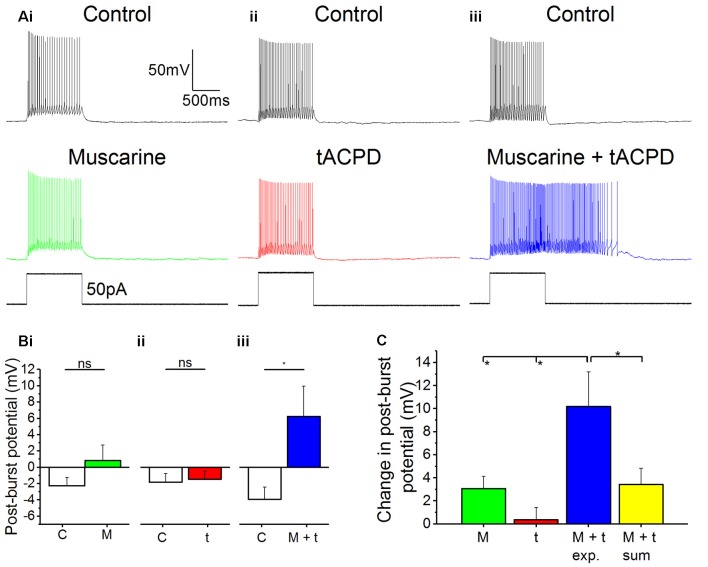
Synergistic effects on post-pulse potential by coapplication of low doses of muscarine and tACPD. (A) Typical responses of OLM cells to a 50 pA 1 s current pulse before and after application of either a low dose muscarine (Ai; 4 μM; n = 8), a low dose tACPD (Aii; 4 μM; n = 8), or both combined (Aiii; 4 μM + 4 μM; n = 6). (B) Summary plots show that no significant change in post-burst potential was seen with application of a low dose of muscarine (Bi; n = 8) or tACPD (Bii; n = 8), whereas a significant increase was seen following application of a low doses of both drugs simultaneously (Biii; n = 6), converting the post-burst potential from and AHP to ADP. (C) The Summary plot for change in post-pulse potential, in all experimental conditions and also post hoc linear sum (yellow column). The linear sum was calculated from eight randomly selected pairs of independent measures of single low dose drug administration. Error bars = SEM. *P < 0.05; ns, not significantly different, P > 0.05.